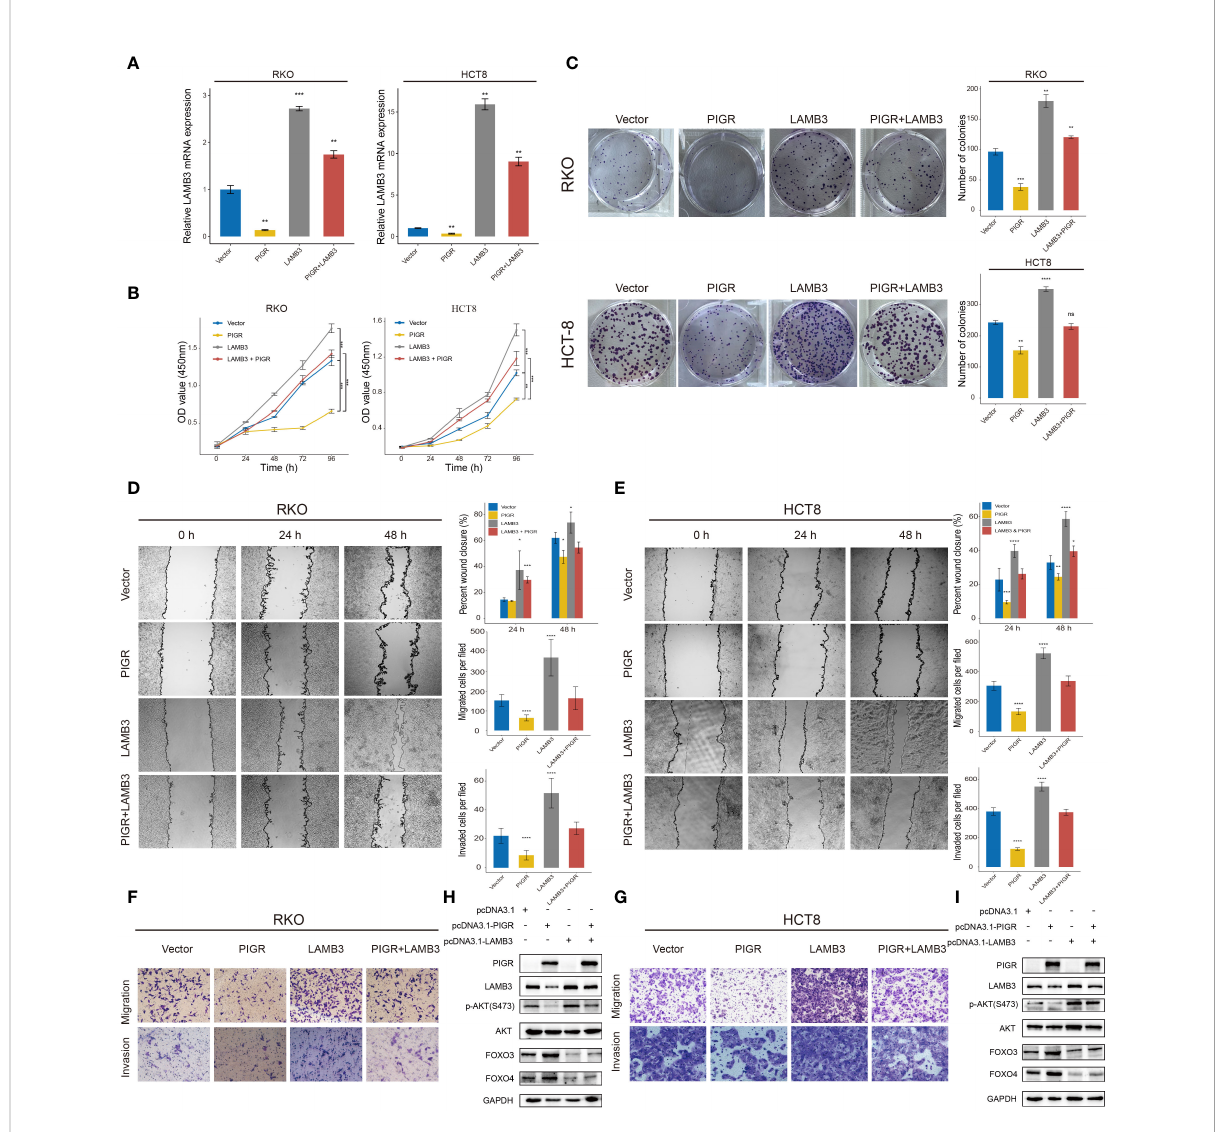
FIGURE 4 PIGR suppresses AKT-FOXO3/4 axis through LAMB3 (A) Relative LAMB3 mRNA expression of empty vector (Vector), PIGR-overexpressing (PIGR), LAMB3-overexpressing (LAMB3) and rescue experiment group (PIGR & LAMB3) in RKO and HCT-8 cells. Differences compared to Vector group (n = 3; one-way ANOVA, P adjusted by FDR). (B) Cell proliferation was detected by CCK-8 assay at 0, 24, 48, 72 and 96 hours in RKO and HCT-8 cells (n = 3; one-way ANOVA, P adjusted by FDR). (C) The colony formation assay of RKO and HCT-8 cells (n = 3; one-way ANOVA, P adjusted by FDR). (D – G) Wound healing, migration, and invasion assays were performed in RKO and HCT-8 cells (n = 3; one-way ANOVA, P adjusted by FDR). (H, I) Western blot showed altered protein levels of AKT-FOXO3/4 axis in empty vector, PIGR-overexpressing, LAMB3- overexpressing and rescue experiment group in RKO and HCT-8 cells. Differences compared to Vector group. Data are presented as the mean ± S.D. * P < 0.05; ** P < 0.01; *** P < 0.001; **** P <